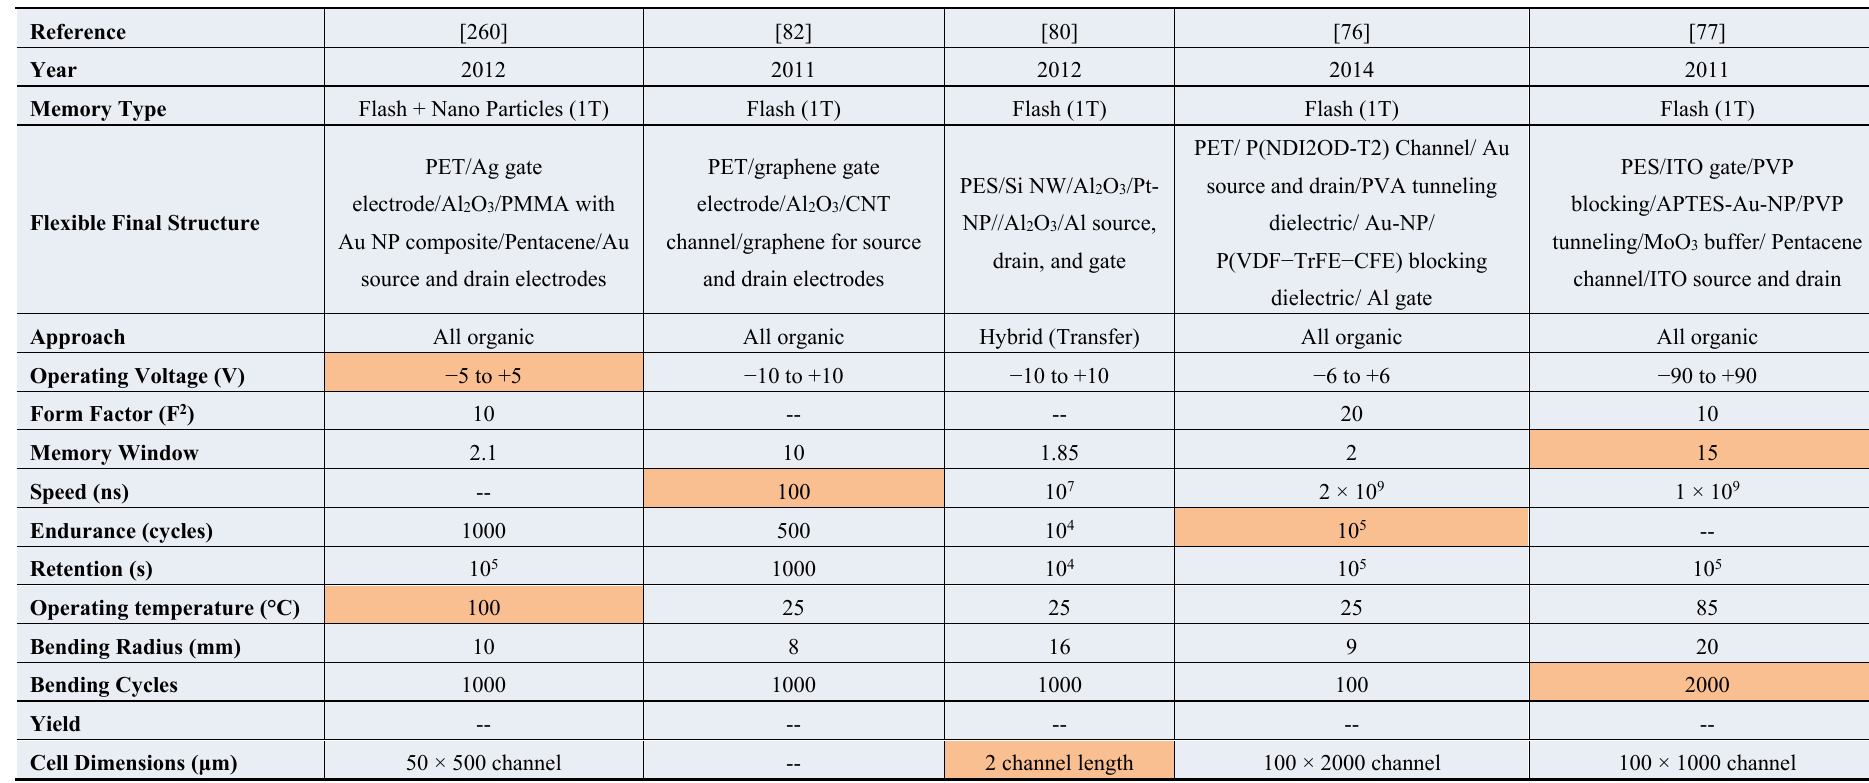
Table 9. Summary of the key works on flexible Flash memory over the past five